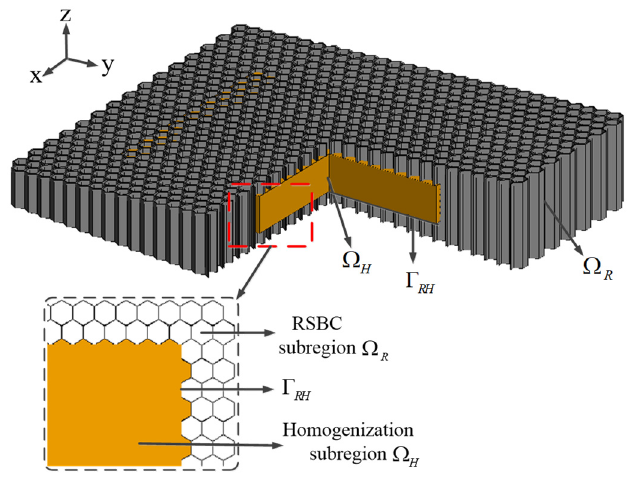
Figure 1. Illustration of a honeycomb structure modeled using the proposed hybrid modeling ap-